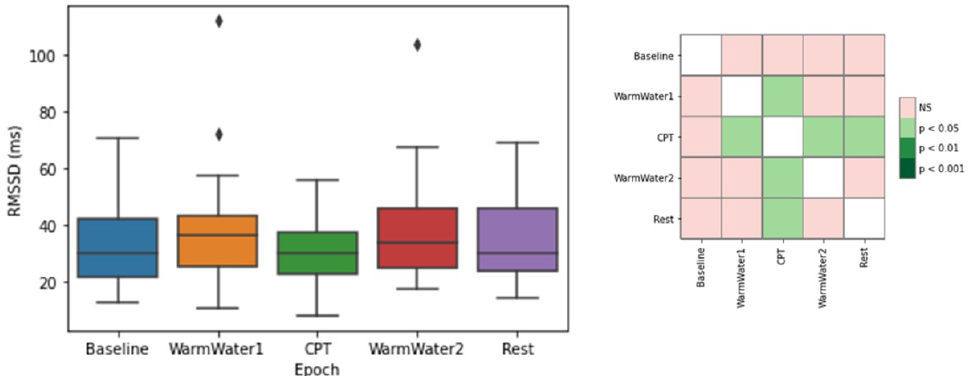
Figure 5. Boxplot for the mean minimum ECG cycles ( left ) and respective matrix of calculated p - values between different epochs, with Bonferroni correction, for the ( right ). The (cid:5) stands for outliers.